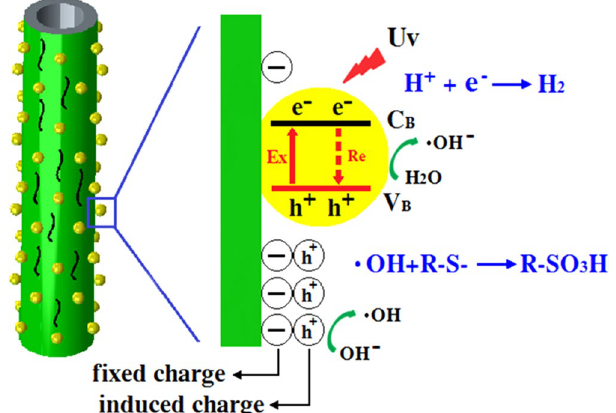
Figure 9. Schematic illustration of the photocatalytic degradation mechanism of MB over HNTs@ZnO nanocomposites under